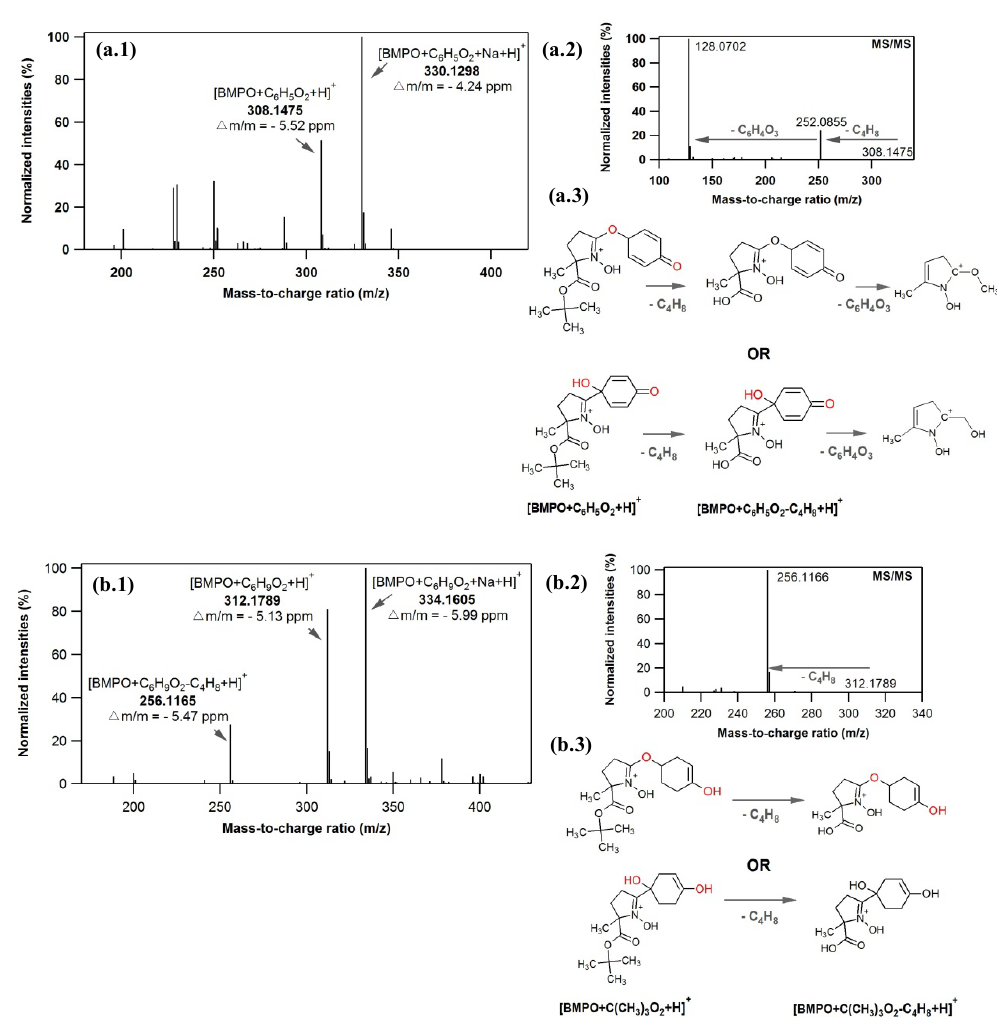
Figure A3. Mass spectra obtained with LC-MS/MS in the positive ionization mode for solution (1). MS spectra of (a.1) BMPO + C 6 H 5 O 2 and (b.1) BMPO + C 6 H 9 O 2 . MS/MS spectra of (a.2) BMPO + C 6 H 5 O 2 and (b.2) BMPO + C 6 H 9 O 2 . Proposed fragmentation pathways